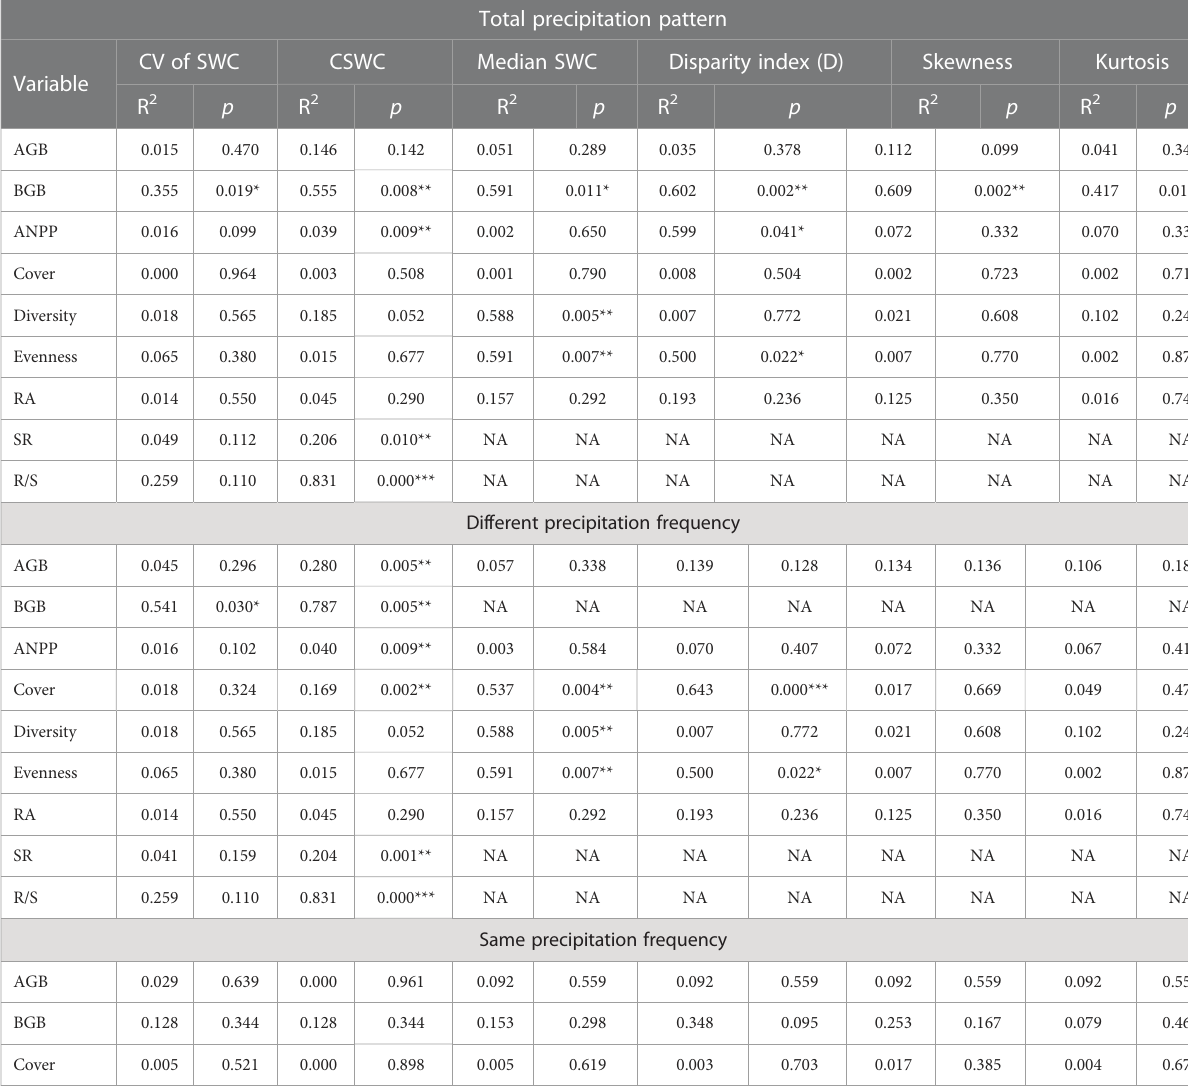
TABLE 1 Effects (R 2 and p -values) of soil moisture indices on plant productivity and community